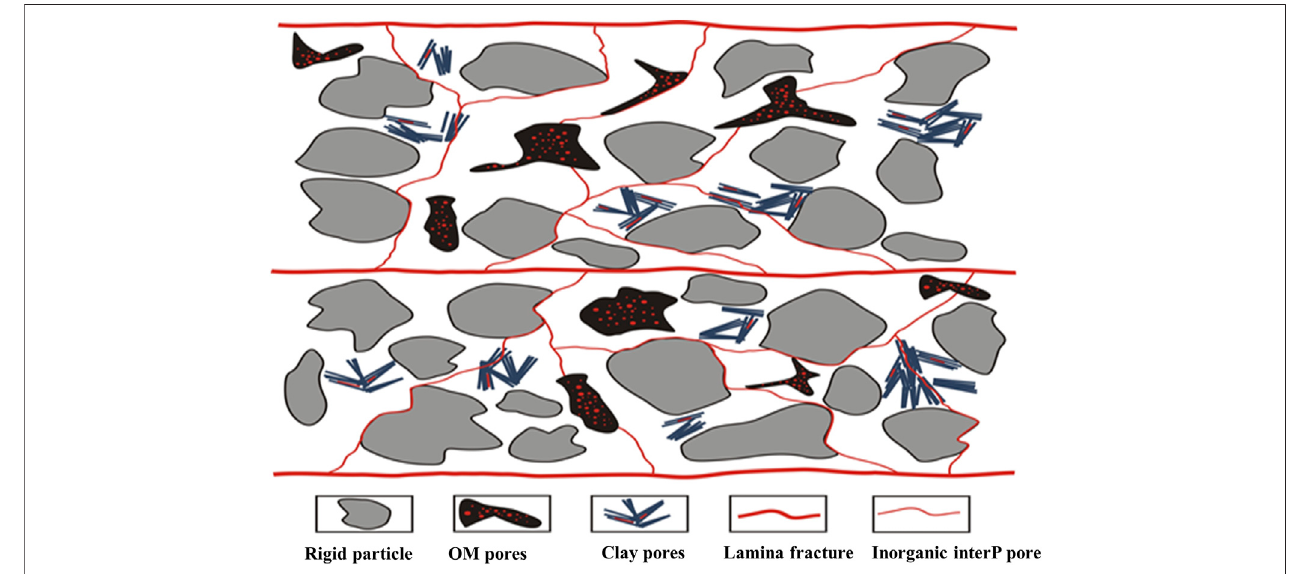
FIGURE 11 | Schematic illustration of favorable interconnected pore systems in